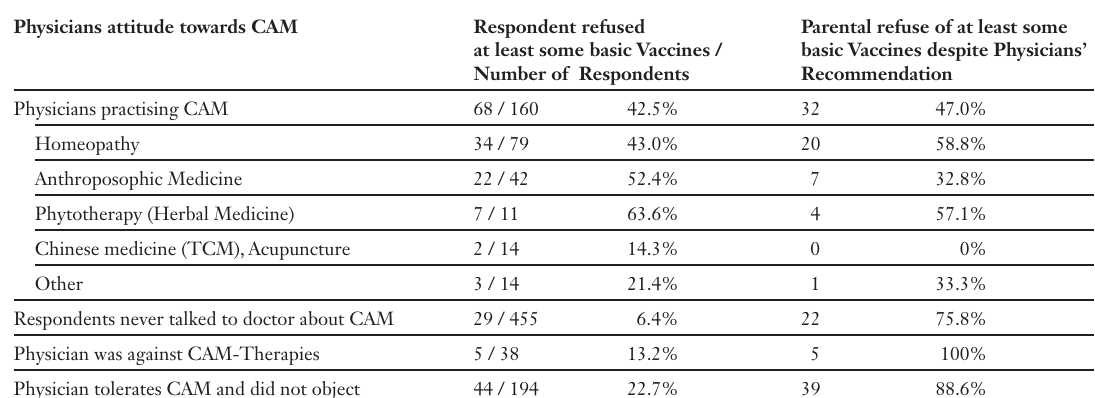
Vaccination-related decisions of the study respondents. The patients were di- vided in two groups: CAM-users and non- users. Data derive from the information given by the respon- dents.